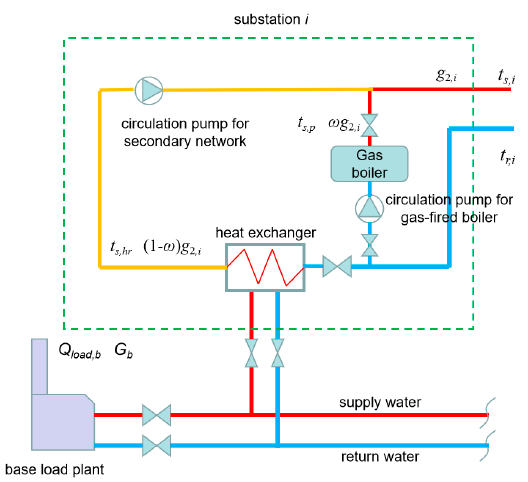
Figure 2. DH system with gas-fired PBs in all heating substations with parallel connection modes. Figure 1 indicates the series connection mode. For heating substation i , the gas-fired PB is placed